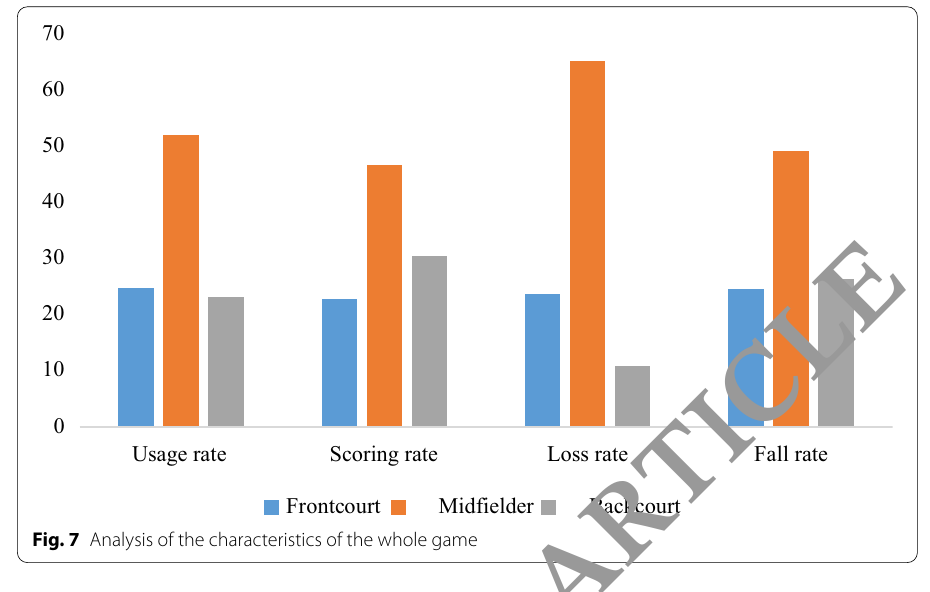
Fig. 7 Analysis of the characteristics of the whole